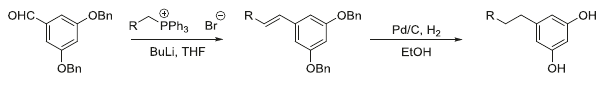
General procedure 1: Olivetol analog synthesis